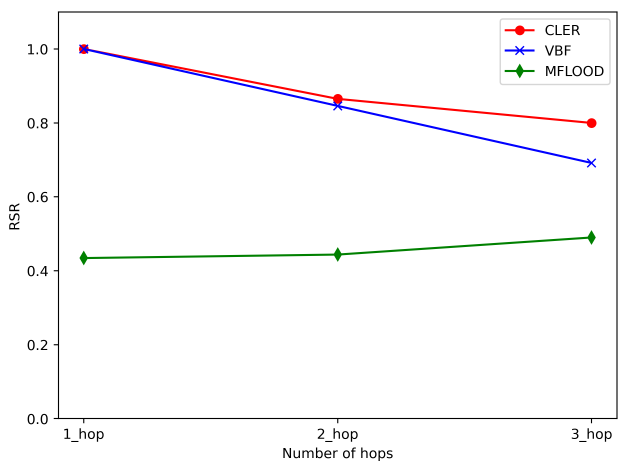
Figure 9. ERSR of different